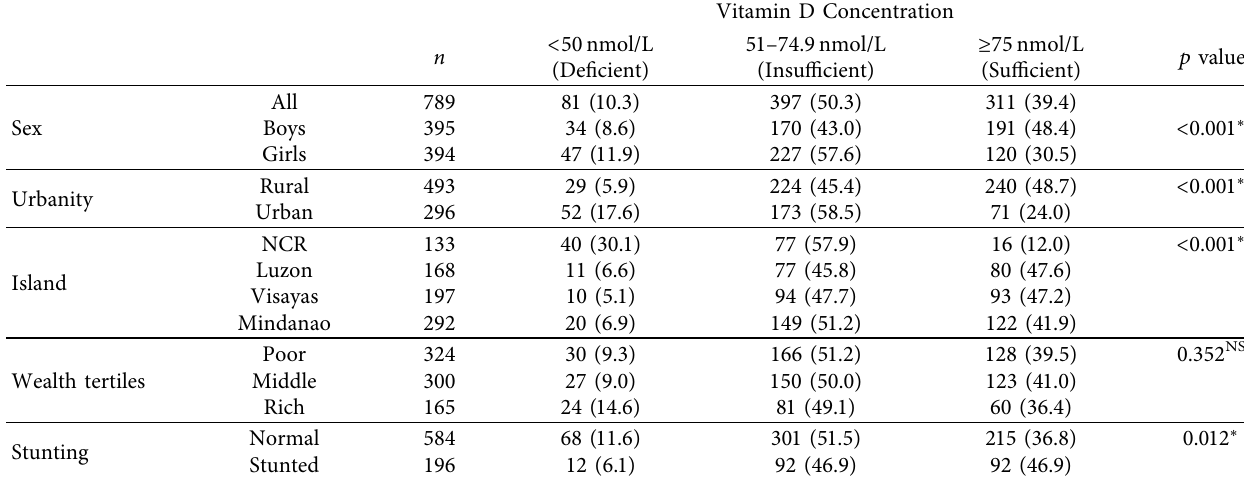
Table 5: Vitamin D serum level status of